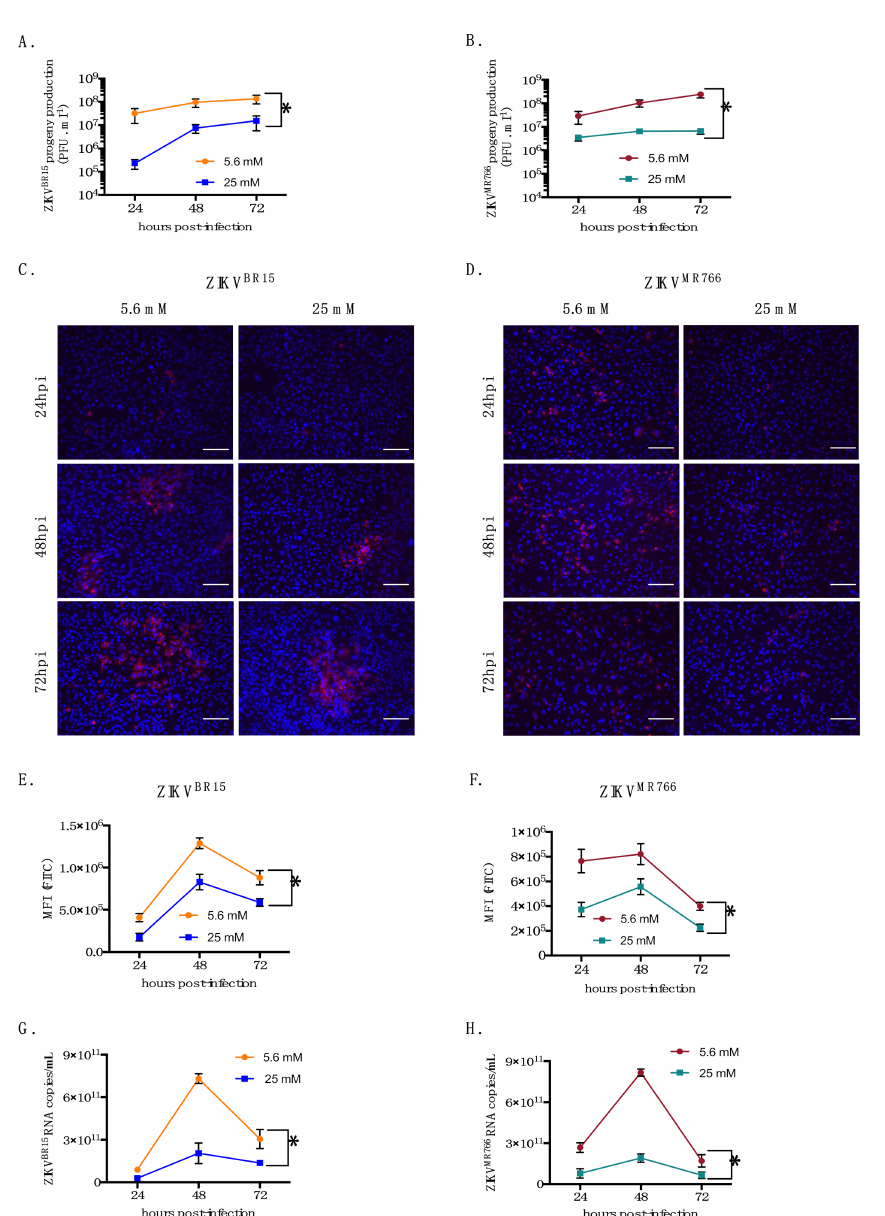
Figure 1. Exogenous glucose interferes on ZIKV growth in HK-2 cells. HK-2 cells were infected with ZIKV BR15 and ZIKV MR766 at MOI of 1. ZIKV progeny production in cell culture supernatants of HK-2 infected cells with ZIKV BR15 ( A ) and ZIKV MR766 ( B ) were quantified by plaque-forming assay at 24, 48, and 72 hpi. Detection of intracellular E protein in ZIKV BR15 ( C ) and ZIKV MR766 ( D ) infected HK-2 cells at 24, 48, and 72 hpi by immunofluorescence using anti-E pan flavivirus monoclonal antibody (mAb) 4G2-Alexa Fluor 596. The ZIKV E protein (red) and nuclei (blue) were visualized by fluorescence microscopy. In ( E , F ) flow cytometry was performed and E protein was detected in ZIKV BR15 and ZIKV MR766 HK-2 infected cells, respectively using anti-E pan flavivirus mAb 4G2. The number of viral genomic RNA in ZIKV BR15 ( G ) and ZIKV MR766 ( H ) -infected HK-2 cells was determined at 24, 48, and 72 hpi by RT-qPCR. Results are shown as means ± SEM of three independent experiments. Two-way ANOVA test shows that differences are statistically significant (* p < 0.05). Scale bars represent 100 µ